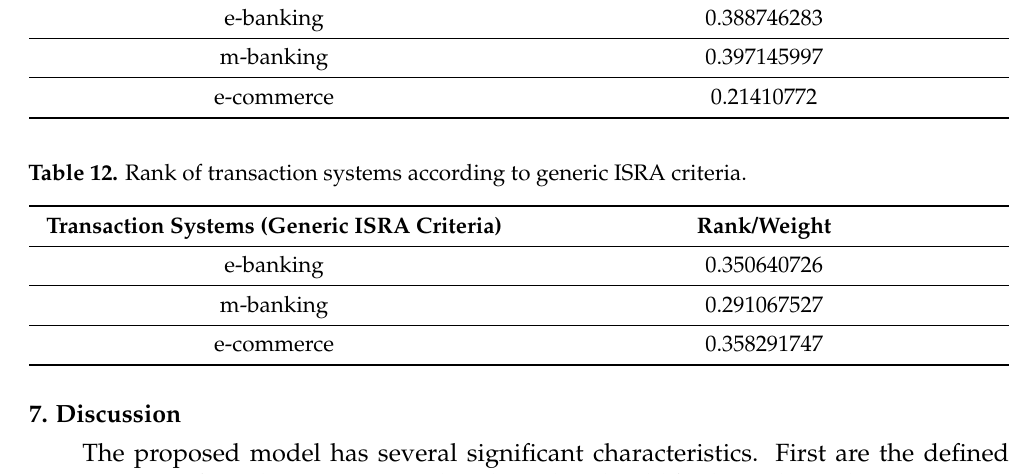
Table 11. Rank of online transaction systems according to inherent criteria. Transaction Systems (Inherent Criteria)